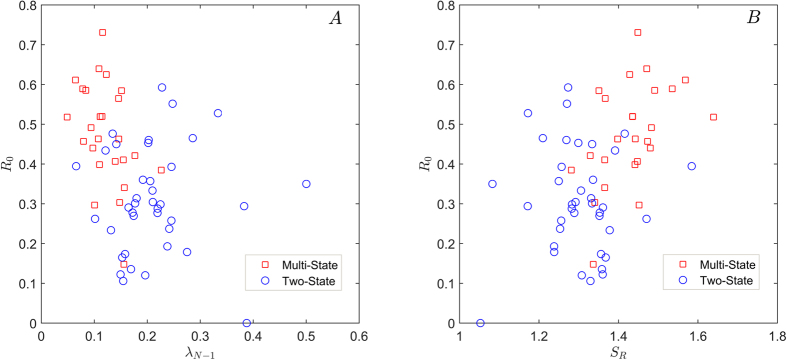
Scatterplots of two top-ranking classification couples of observables.Panel A: λN−1 and R0 (classification = 88.3% ± 1.1%, MCC = 0.76 ± 0.02). Panel B: SR and R0 (classification = 84.5% ± 1.3%, MCC = 0.67 ± 0.03).